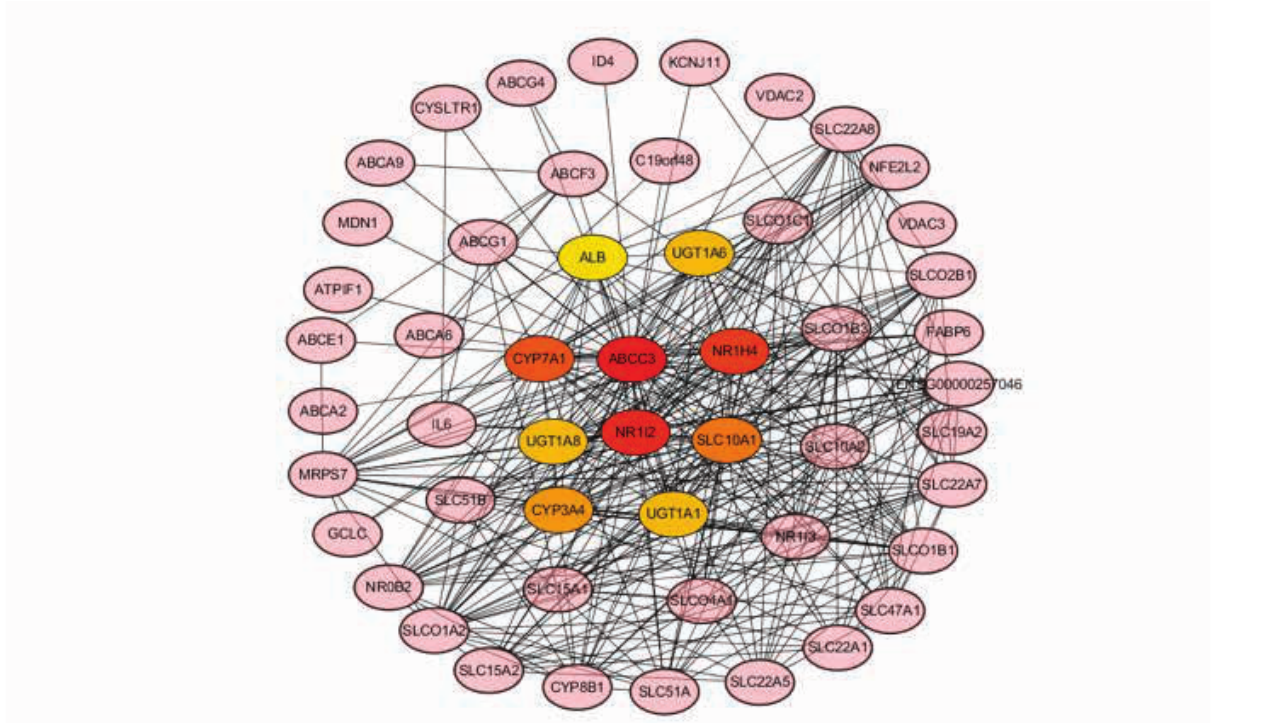
Figure 3: Network of hub genes identification by cytoscape